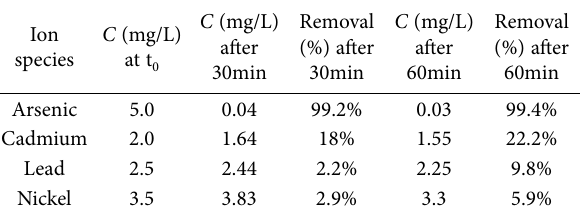
Table 6. A comparison of arsenic, cadmium, lead and nickel remov- al rates observed in the ion flotation process using N-octanoyl-cys surfactant. The batch process had an initial surfactant concentration of 0.01M and pH=8.